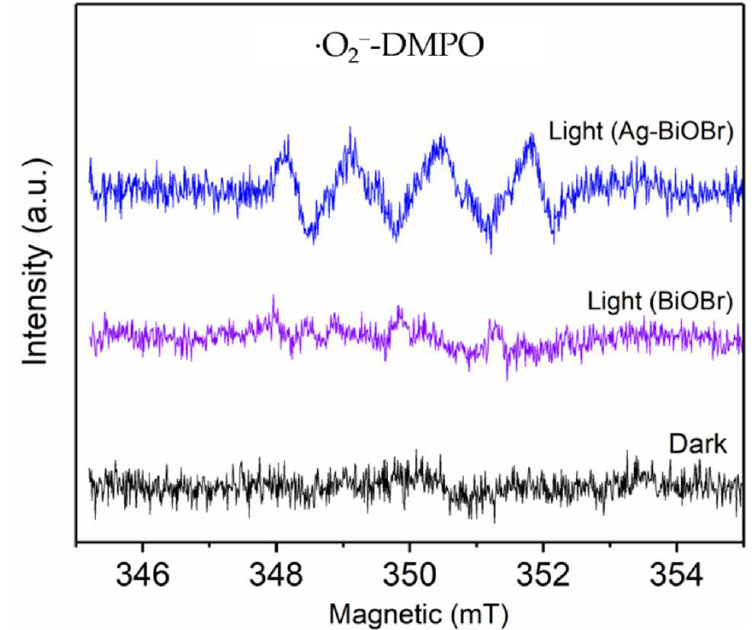
Figure 7. EPR spectra of BiOBr and Ag-BiOBr.